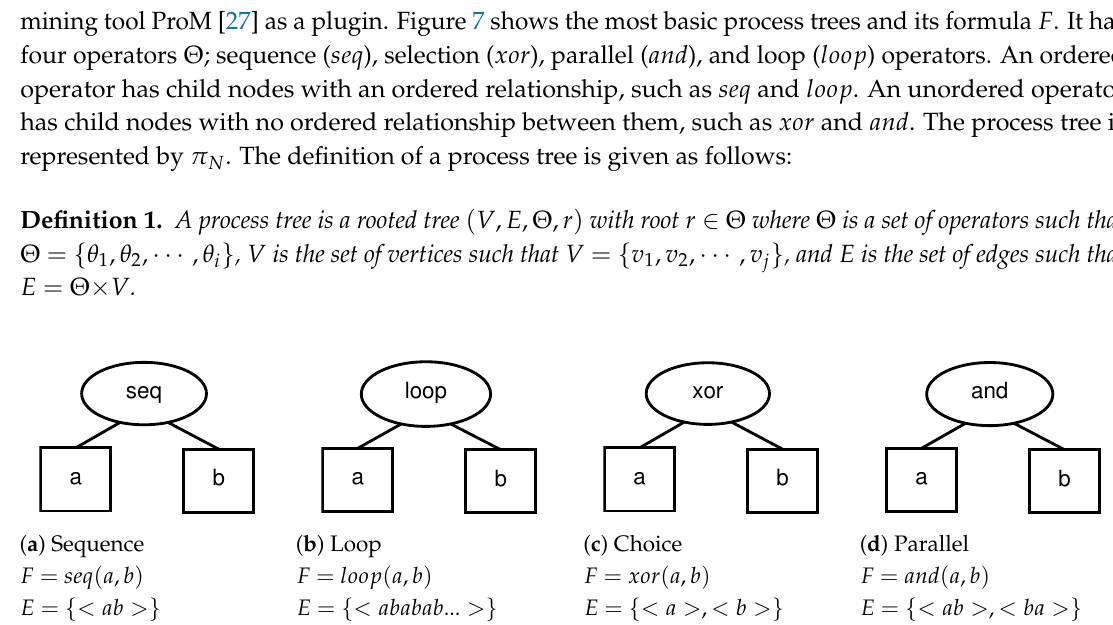
Figure 7. Process tree Π with the equivalent process tree formula F and trace E . seq and loop are ordered operators in which the trace E must follow the sequence of the action from left to right, as shown in the process tree. xor and and are non-ordered operators where the actions do not need to follow sequence order.